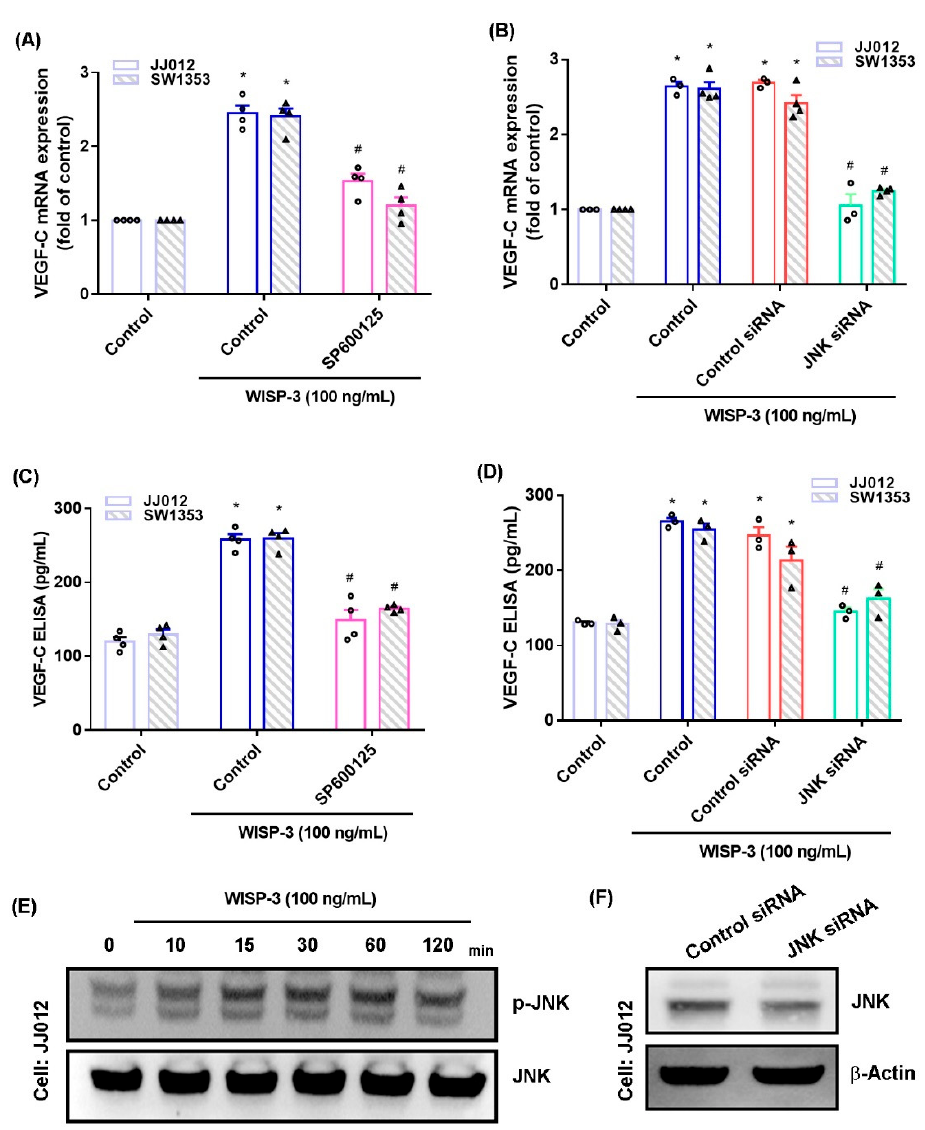
Figure 3. The JNK pathway controls WISP-3-induced VEGF-C production. ( A – D ) Cells were pretreated with a JNK inhibitor (SP600125) or transfected with a JNK siRNA, then stimulated with WISP-3. The levels of VEGF-C expression were examined by qPCR and ELISA. ( E ) JJ012 cells were incubated with WISP-3 for the indicated time intervals, and JNK phosphorylation was examined by Western blot. ( F ) JJ012 cells were transfected with JNK siRNA, and JNK expression was examined by Western blot. Quantitative results are expressed as the mean ± SD. All experiments were repeated 3 to 5 times (solid squares, solid dots, hollow circles and solid triangles). * p < 0.05 compared with the control group; # p < 0.05 compared with the WISP-3-treated group.